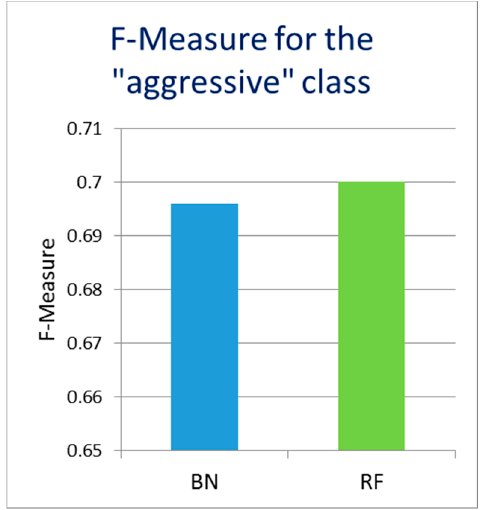
Figure 8. F-Measure of classification of aggressive driving for the data collected with only smartphone before the driving, without using the car door data.